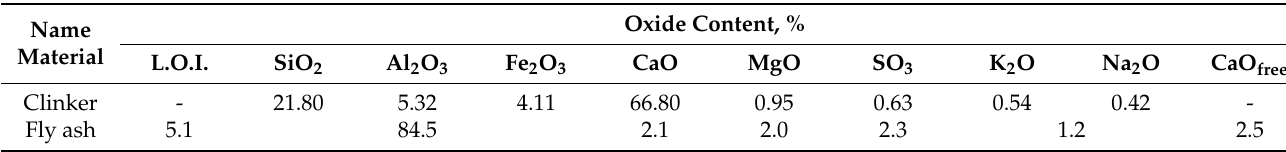
Table 2. Chemical composition of raw materials.